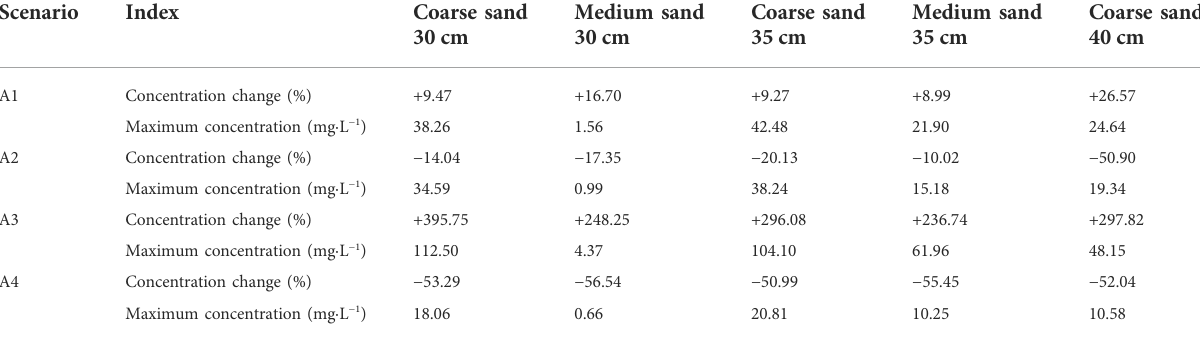
TABLE 7 Variation in Pb concentration in water under four simulated